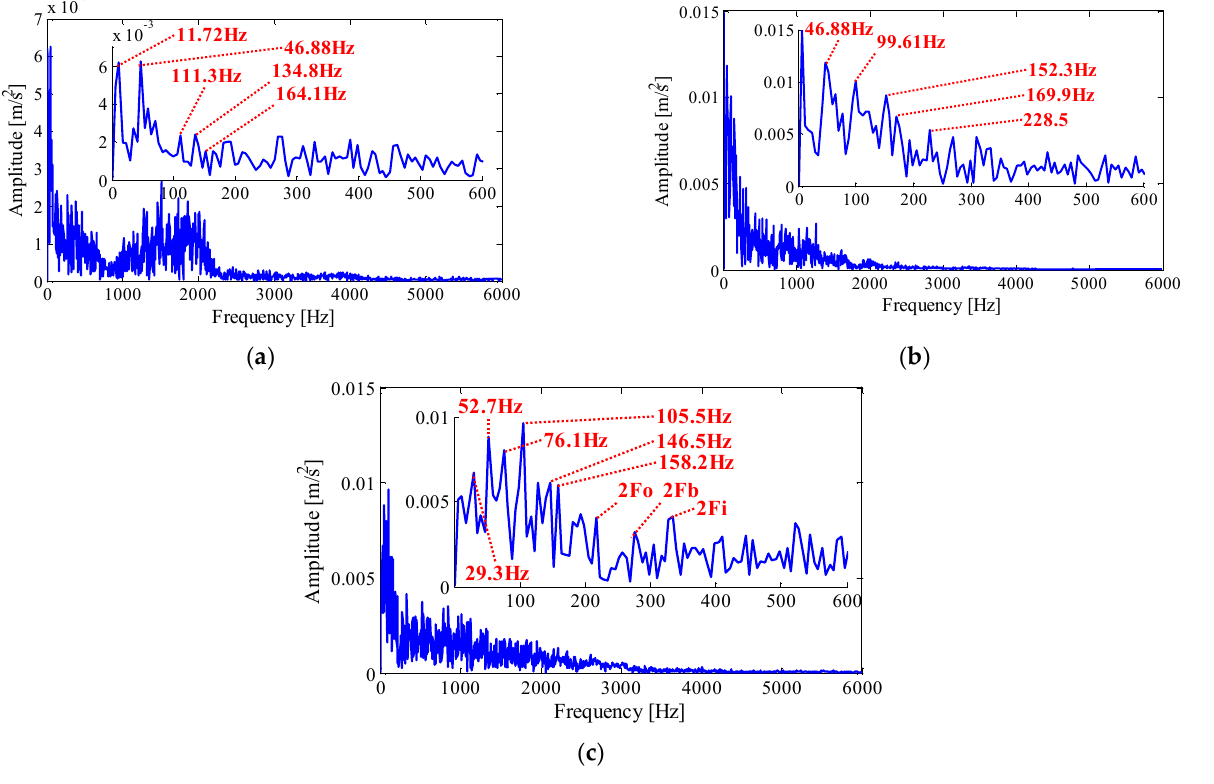
Figure 24. The envelope spectrum of the sensitive IMF obtained by ( a ) TVF-EMD with assigned parameters, and ( b ) TVF-EMD based on GOA ;( c ) TVF-EMD based on IGOA.